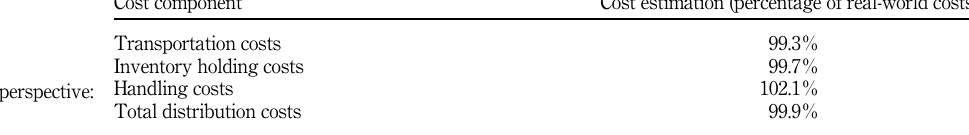
Table II. Economic perspective: model